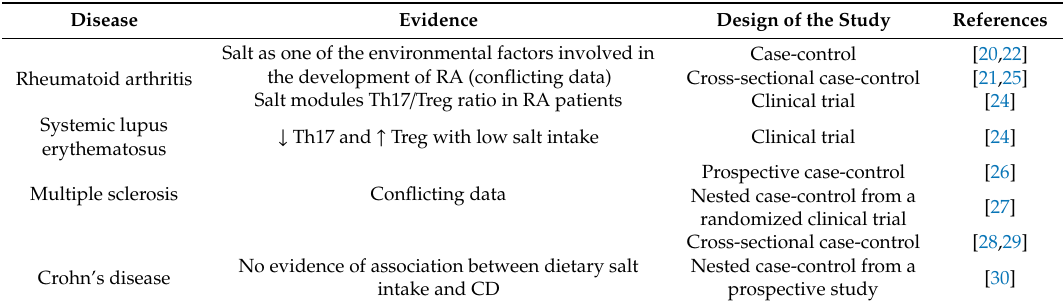
Table 2. E ff ect of sodium intake on immune response in published